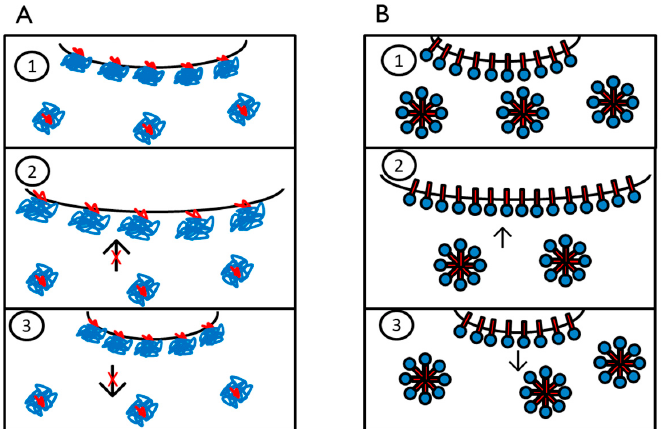
Figure 3. Schematic differences at the air–water interface between β -lactoglobulin ( A ) and polysorb- ate 80 ( B ) samples during oscillation. bate 80 ( B ) samples during